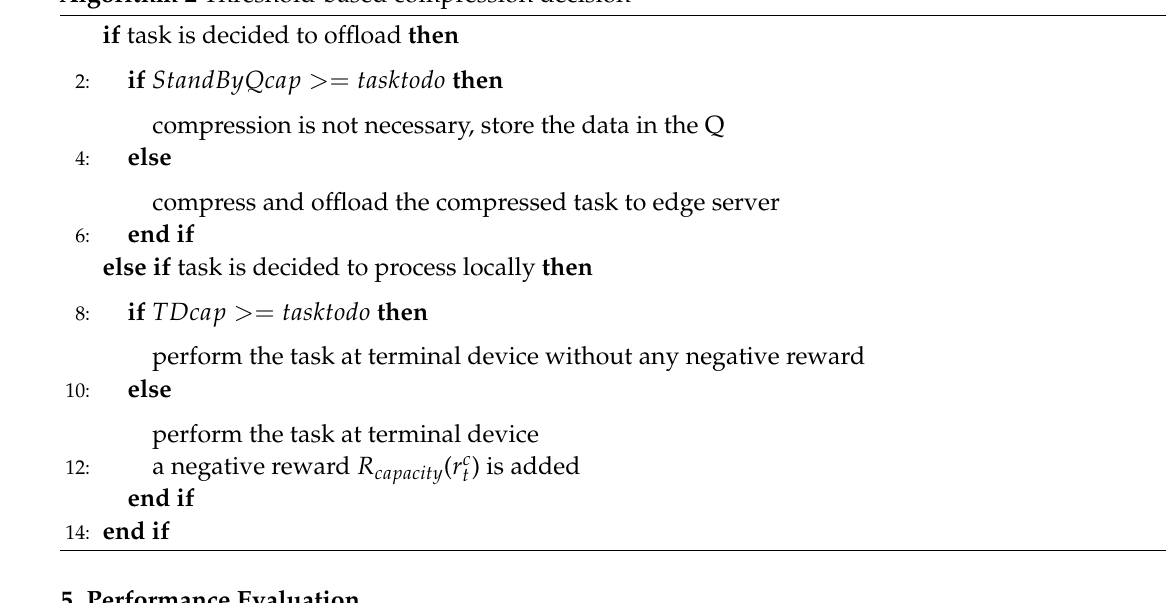
Algorithm 2 Threshold-based compression